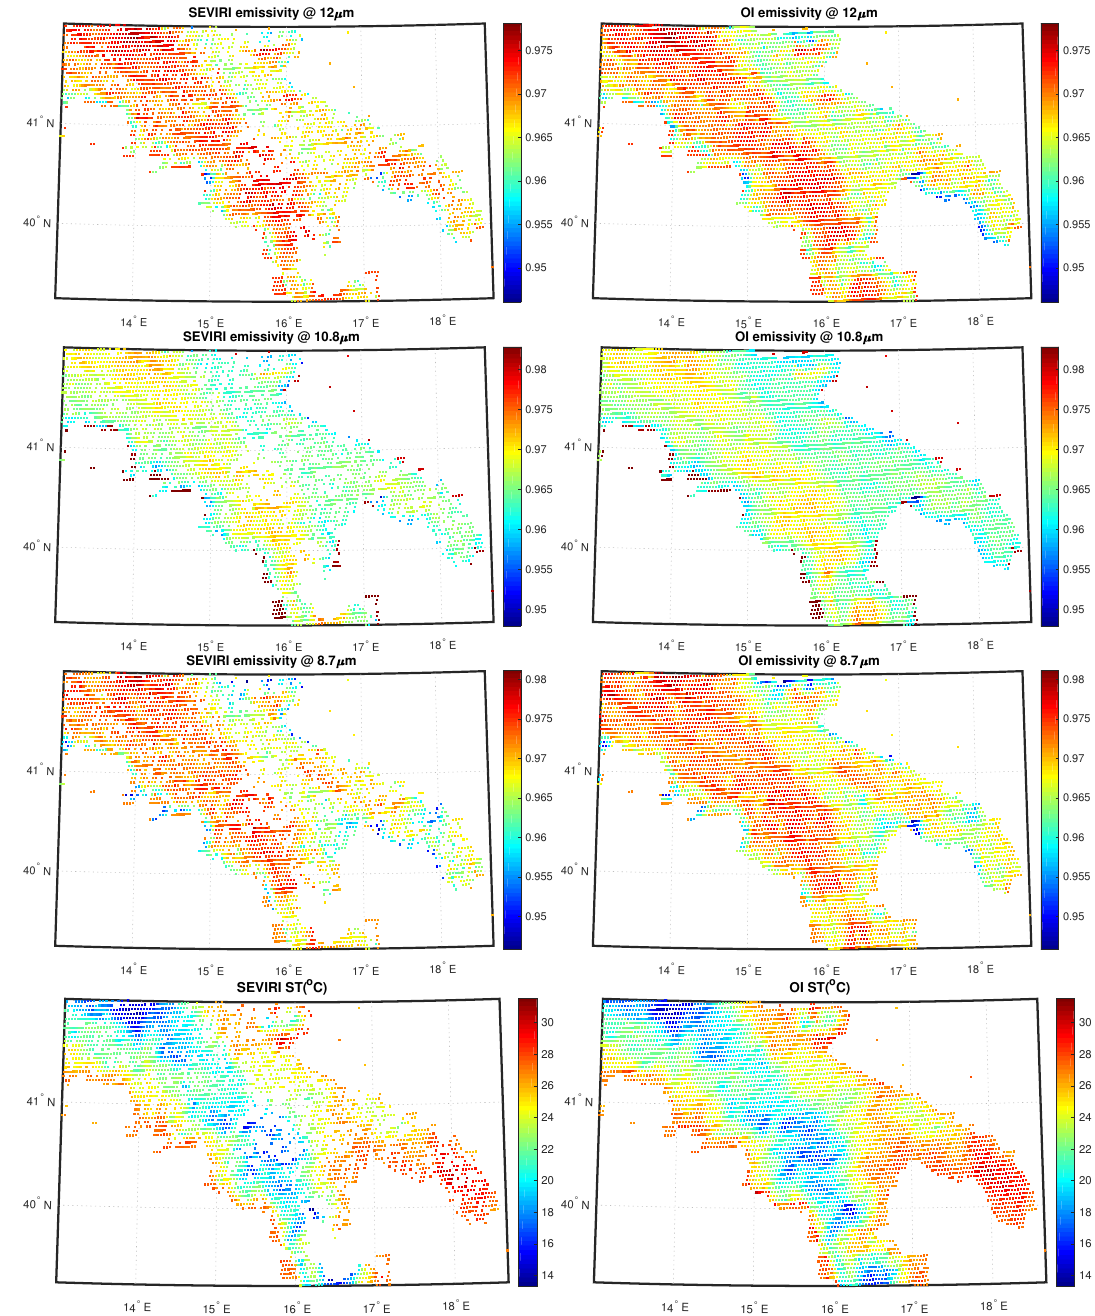
Figure 6. L2 and L3 SEVIRI fields for emissivity and ST over land corresponding to 11 August 2013 00:06